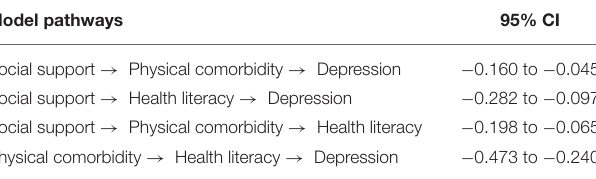
TABLE 6 | Significance tests of mediating